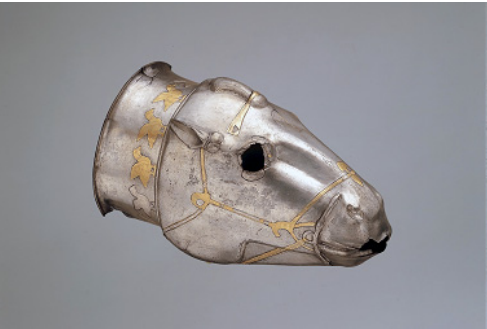
Figure 6. Vessel in shape of horse’s head (MMA acc. no. 47.100.87); rhyton, gilded silver; Iran;